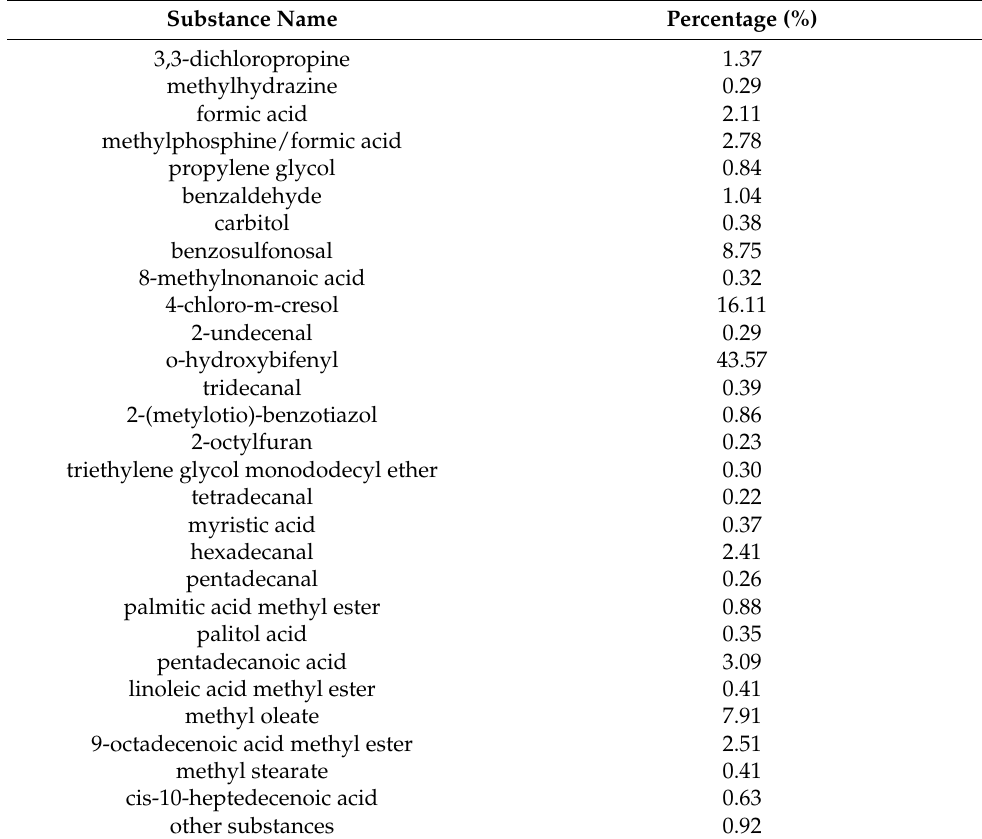
Table 3. Results of the VOC analysis.